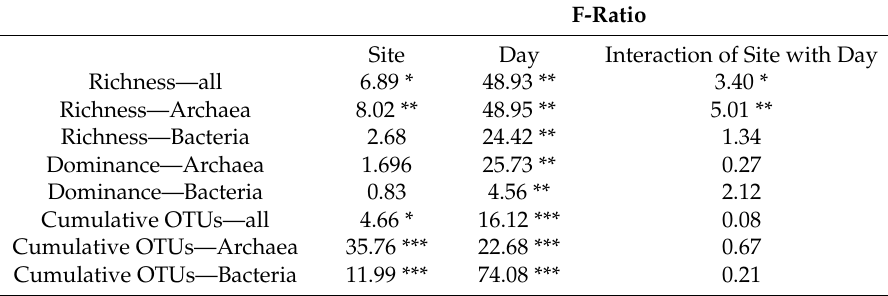
Figure 2. Means with standard errors of OTU ( a ) richness, ( b ) cumulative OTU richness, and ( c ) dominance for Bacteria (grey triangles) and Archaea (white circles) throughout the course of the experiment (day 0, day 5-exponential phase, day 17-stationary phase) in the three different sites of origin (Banyuls, Pagasitikos and Woods Hole). Table 1. The effect of the site of origin of the inoculum (Banyuls, Pagasitikos, Woods Hole) and day of the experiment (Day 0, day 5-exponential phase, and day 17-stationary phase) and their interaction, on different aspects of prokaryoplankton community structure (richness, cumulative OTUs and dominance). Single asterisks denote that the null hypothesis (no effect) is rejected at the 0.05 level, double asterisks at the 0.01 level and triple asterisks at the 0.001 level based on the respective F-ratio value.